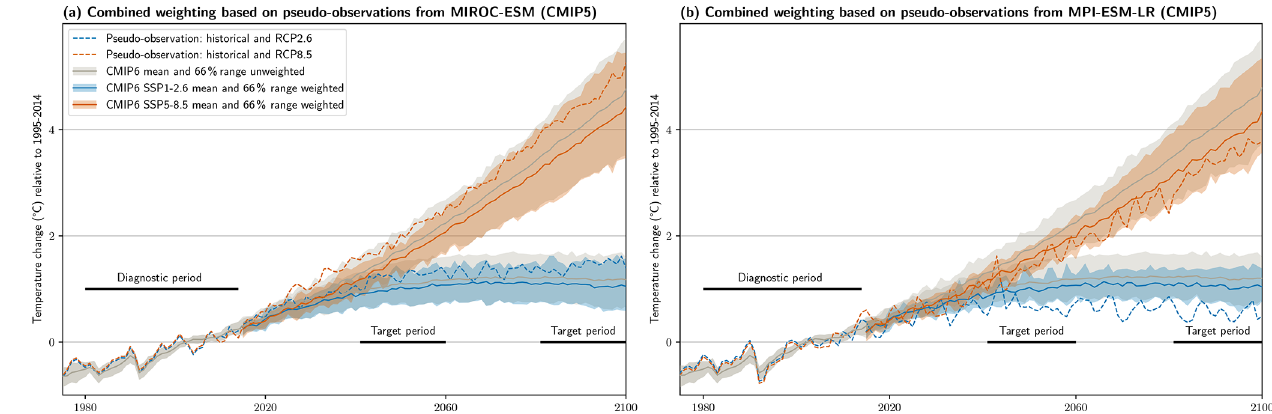
Figure 2. Time series of temperature change (relative to 1995–2014) for the unweighted (gray) and weighted (colored) CMIP6 mean (lines) and likely (66%) range (shading) as well as the CMIP5 models serving as pseudo-observations (dashed lines). Shown are the cases that lead to (a) the largest decrease in skill (CMIP5 pseudo-observation: MIROC-ESM) and (b) to the largest increase (MPI-ESM-LR) for SSP5-8.5 in the end-of-century target period. Note that no inference on the performance of the CMIP5 models can be drawn from this figure. The diagnostic period refers to the 1980–2014 period, which informs the weights; the target periods refer to 2041–2060 and 2081–2100.